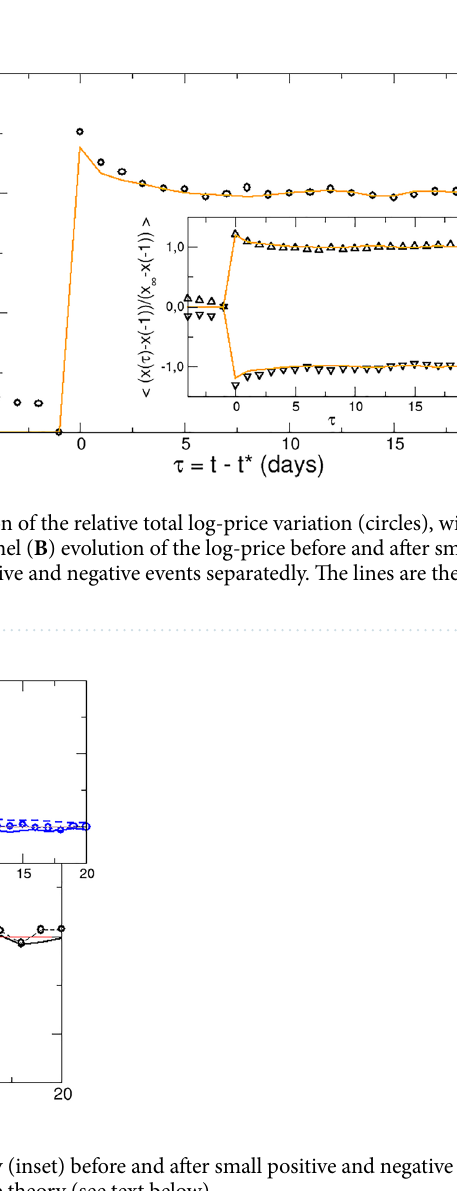
value is presented. This shows an overshoot at t ∗ , namely when the event takes place, followed by a decay within a few days to reach a steady value ( x ∞ is the average log-price between 10 and 20 days after the event). The inset shows positive and negative events separatedly. In addition to the log-price, the dynamics of stocks is also monitored considering the corresponding log- return and volatility. (The latter represents how fast the price changes, irrespective of the sign of the change, and is calculated as v 2 i ( t ) ). The average normalized evolution of the one day return and volatility after an event are shown in Fig. 2. The average log-return for a positive (negative) event increases (decreases) at the event, and decreases (increases) abruptly immediately after it, followed by a slow relaxation to the equilibrium value. The figure represents the normalized evolution averaged for positive and negative events. The volatility, on the other hand, increases at t ∗ and then decreases to the “equilibrium” magnitude at both positive and negative events. Figures 1 and 2 show that the evolution of the log-price, log-return and volatility is abrupt at the event, and then relaxes to a steady value for a few days. From a physical point of view, this indicates that these variables display memory, and according to LRT, the correlation functions with variable A ( t ), conjugate of the force, should decay with a time scale of a few days. In order to identify this variable, the log-price, log-return and volatility autocorrelation functions (ACF) have been studied (see “Methods”). They are presented in Fig. 3 and show very different behaviour: whereas the log-return reaches negative values within the first day and then relaxes to zero (resembling the velocity ACF in hard spheres), and the volatility ACF presents a similar time scale, but a monotonous decay, the time scale of the log-price ACF is ∼ 50 days. For the purpose of applying LRT, the log-return is more appropriate due to the similarity with the time scale and behaviour of its response function. Therefore, we tentatively identify the log-return, v ( t ), as the conjugate variable,